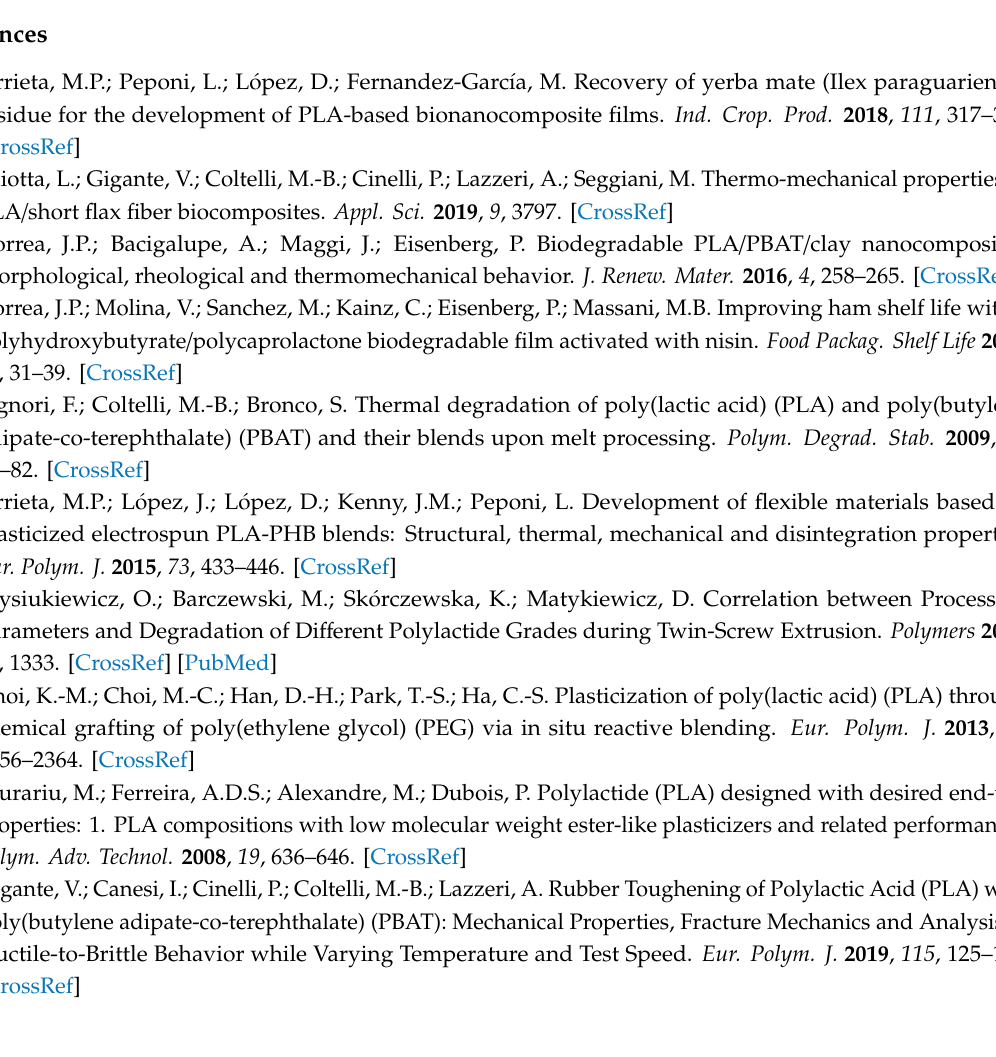
Figure S1: IR spectra of the PLA and PLA / ATBC samples (A) 60 rpm and (B) 150 rpm. Figure S2. TGA thermograms of the samples of (a) PLA with ATBC at 10, 20 and 30% extruded to 60 rpm. (b) PLA with ATBC at 10, 20 and 30% extruded to 150 rpm. Figure S3: Derivative TGA curves of the samples of (a) PLA with ATBC at 10, 20 and 30% extruded to 60 rpm. (b) PLA with ATBC at 10, 20 and 30% extruded to 150 rpm. Figure S4: DSC thermograms of the samples of (a) PLA with ATBC at 10, 20 and 30% extruded to 60 rpm. (b) PLA with ATBC at 10, 20 and 30% extruded to 150 rpm. Figure S5: Micrographs obtained by SEM with magnifications of 500x for (a) PLA, (b) PLA60, PLA60-10 and PLA60-30, (c) PLA150, PLA150-10 and PLA150-30. Table S1. Zero shear viscosity, characteristic relaxation time and molecular weight from the rheological data of PLA and PLA with